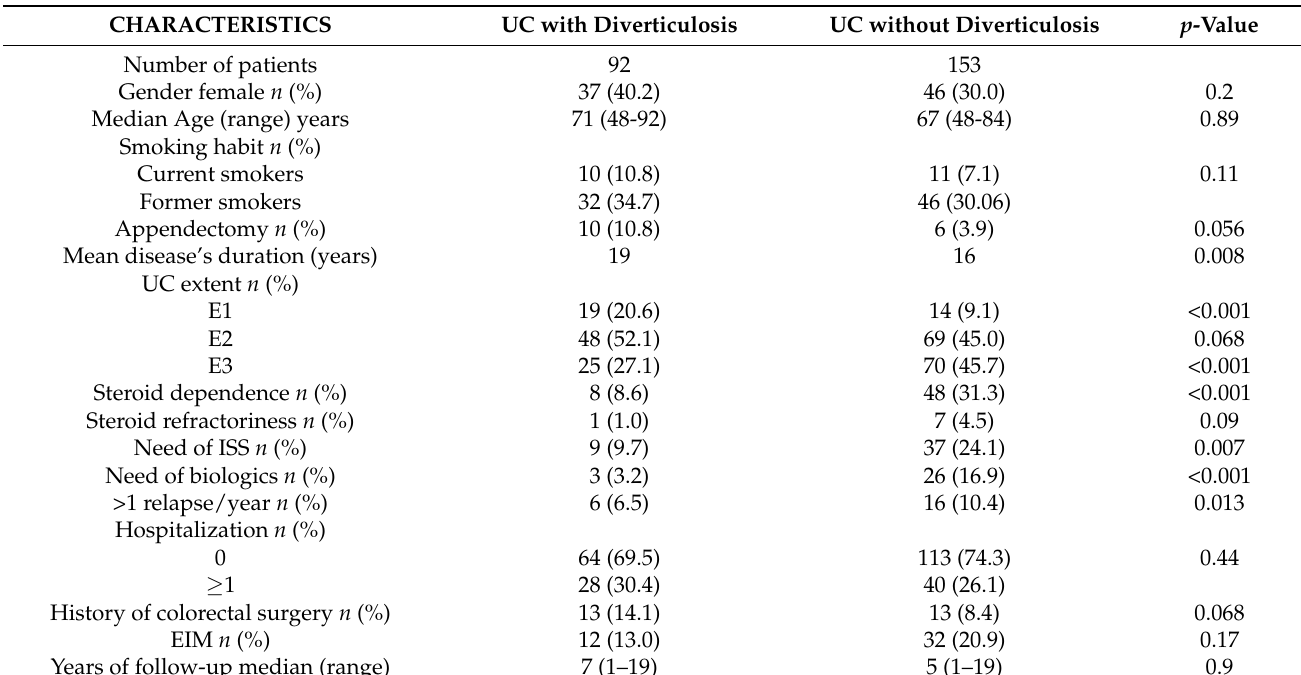
Table 2. Demographic and clinical characteristics of UC patients with diverticulosis and UC patients without diverticulosis upon propensity score matching. Numbers indicate the number of patients for each variable. CHARACTERISTICS